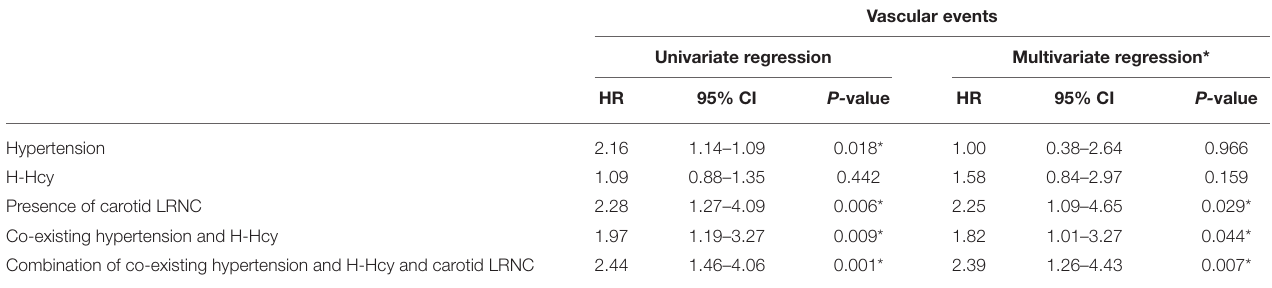
TABLE 4 | Cox regression hazard models of risk factors for vascular